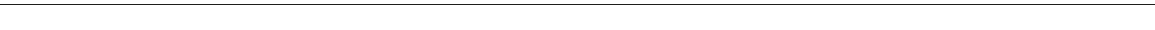
Fig. 5 Ensemble of IL3R α MD simulations in isolation and in complex with wild-type IL-3 and IL-3 K116W. a Snapshots from 75 ns (unliganded/apo IL3R α ) and 100 ns (binary complexes) MD simulations overlaid via the IL3R α CRM (ie, D2 – D3). The mobility of the NTD progressively decreases when going from the unliganded/apo IL3R α (purple NTD, left), to the wild-type IL-3 binary complex (pink NTD, middle) and then to the IL-3 K116W binary complex (green NTD, right). The IL3R α CRM is shown as a dark grey molecular surface, the NTD is shown as a cartoon and the cytokine is depicted as a light grey molecular surface. b Root-mean-square fl uctuation (RMSF) of the C α atoms in IL3R α provides a measure of atom mobility around its average position during the simulation. The data demonstrates that IL-3 K116W stabilises the NTD in the binary complex. Colour scheme and IL3R α alignment as for a . The location of the β -strands (black lines) and the disulphide bonds (red lines) are shown below the X -axis. c Comparison of full-length IL3R α vs IL3R α SP2 mobility in the wild-type IL-3 binary complex. Snapshots from the 100 ns MD simulations overlaid via the cytokine (grey molecular surface). IL3R α shown as a pink cartoon. Loss of the NTD has little impact upon the conformational mobility of the α -subunit. d Comparison of full-length IL3R α vs IL3R α SP2 mobility in the IL-3 K116W binary complex. Snapshots from the 100 ns MD simulations overlaid via the cytokine (grey molecular surface). IL3R α shown as a green cartoon. Loss of the NTD has a visible negative impact upon the conformational mobility of the α -subunit and it now resembles the wild-type